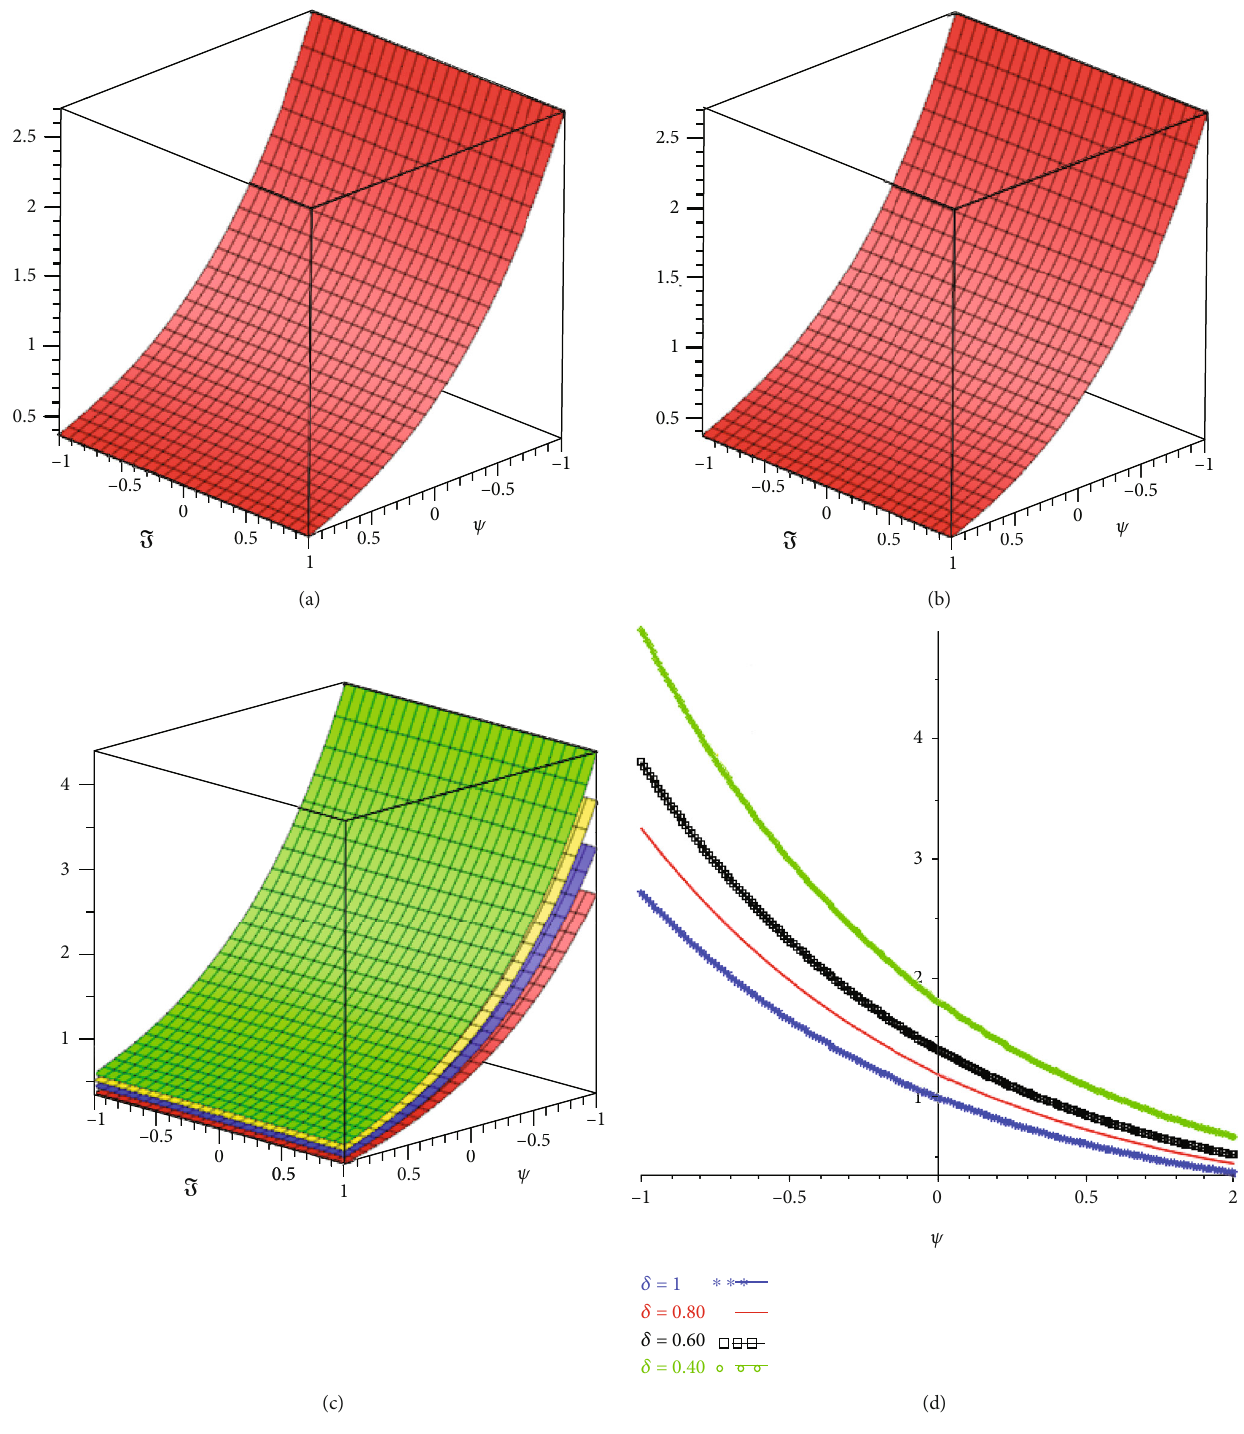
Figure 2: Example 2 solution graph (a) exact solution, (b) analytical solution at λ = 1, (c) analytical solution at various fractional-orders of δ , and (d) I = 0 : 5